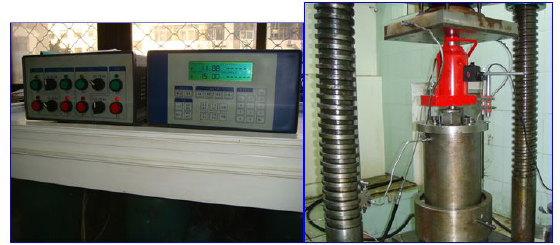
Figure 4. The consolidation